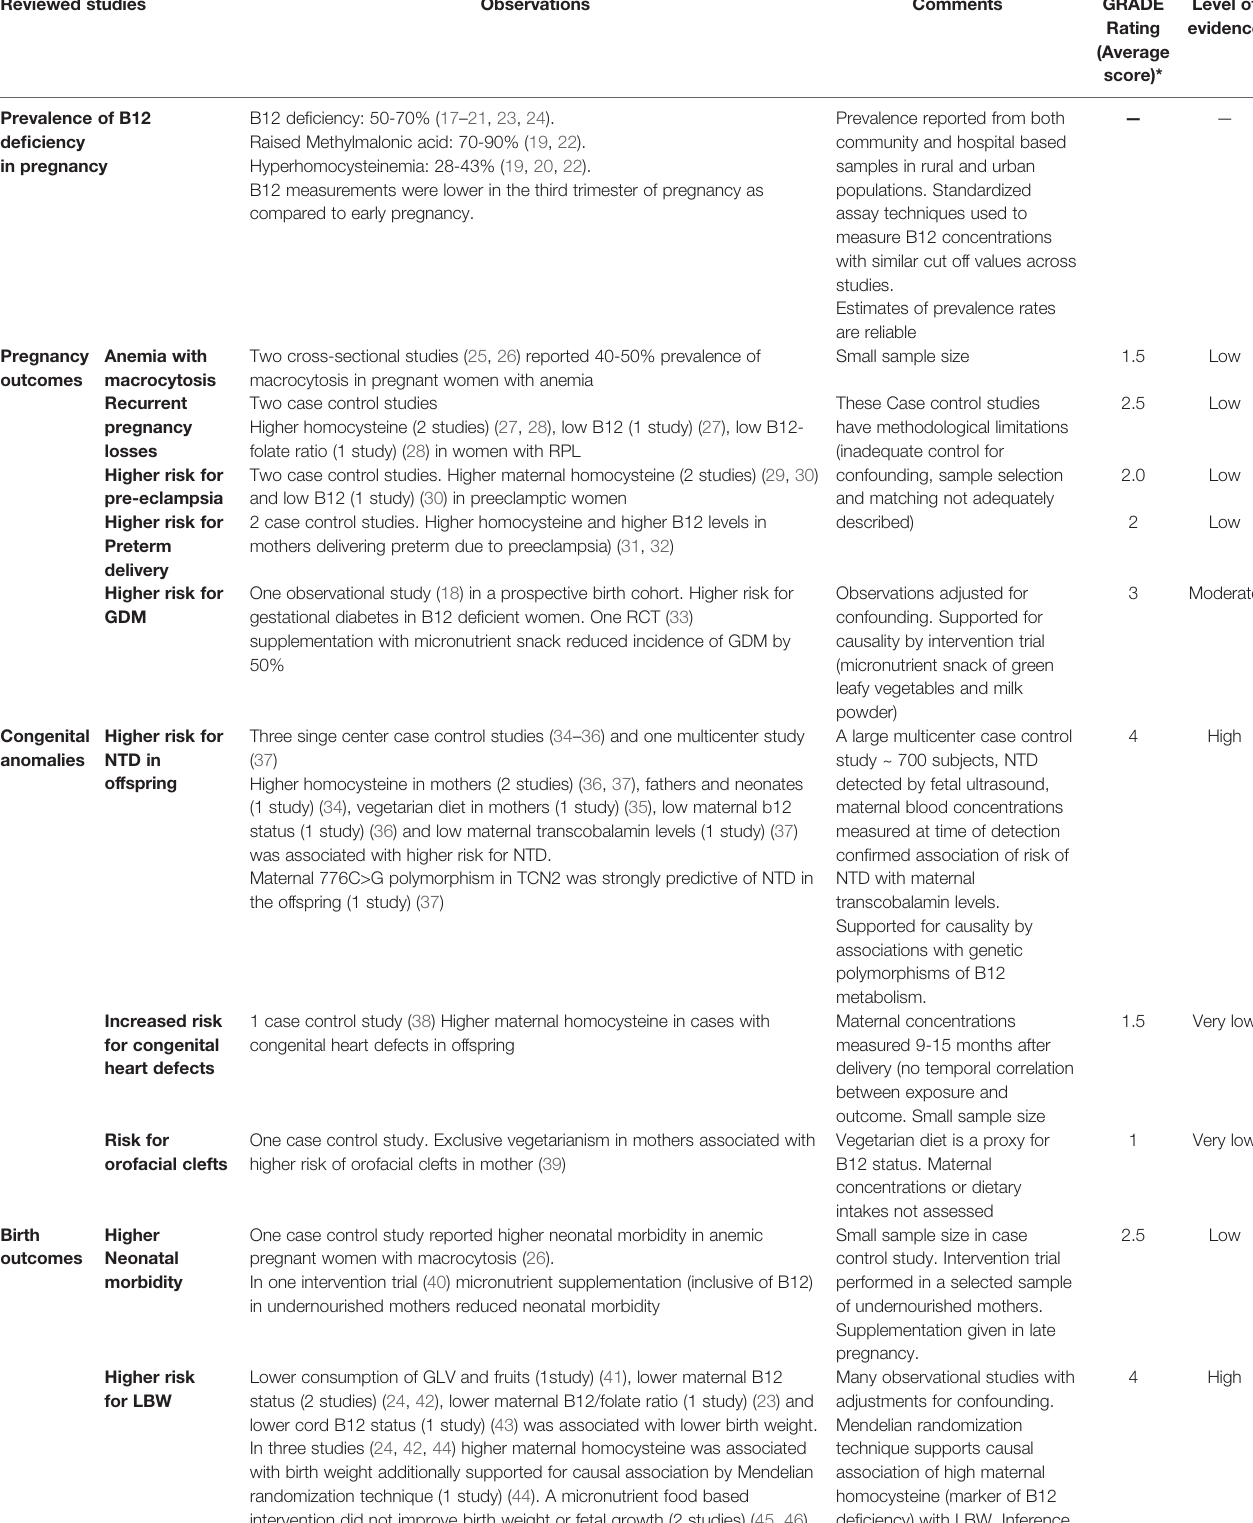
TABLE 2 | Table summarizing the outcomes reviewed with GRADE rating for quality of